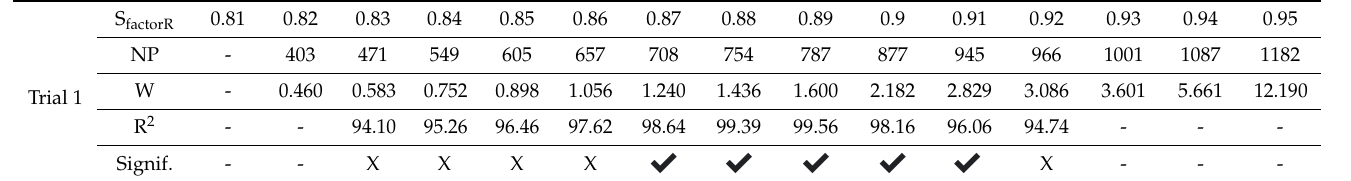
NP max = maximum number of points for maximum sensitivity value. Table 2. Model fit for choice of S factor in Trial 1. Table 2. Model fit for choice of S factor in Trial 1. Table 2. Model fit for choice of S factor in Trial 1. Table 2. Model fit for choice of S factor in Trial 1. Table 2. Model fit for choice of S factor in Trial 1. Table 2. Model fit for choice of S factor in Trial 1. Table 2. Model fit for choice of S factor in Trial